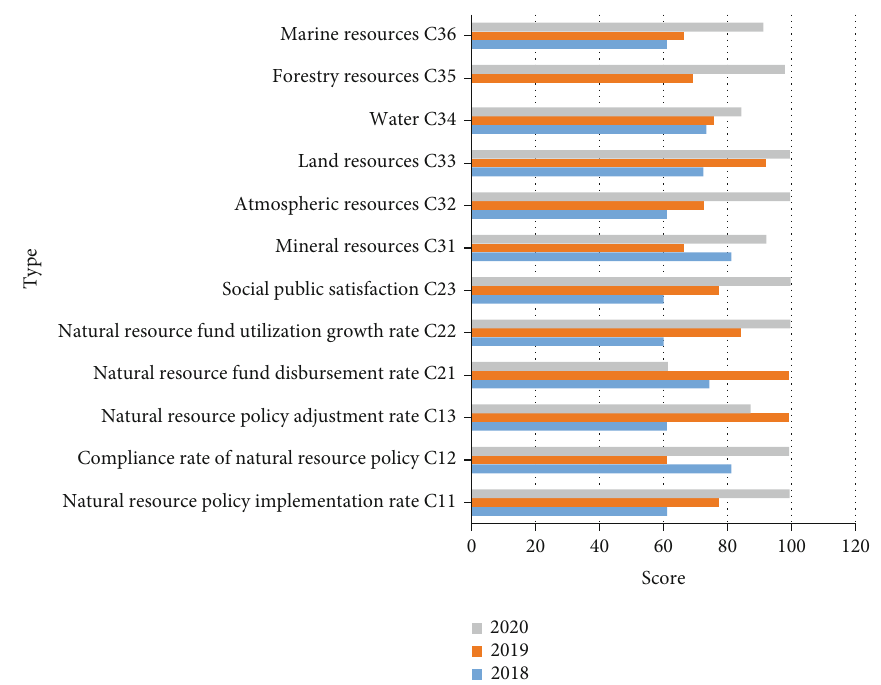
Figure 3: Original NR assessment score.